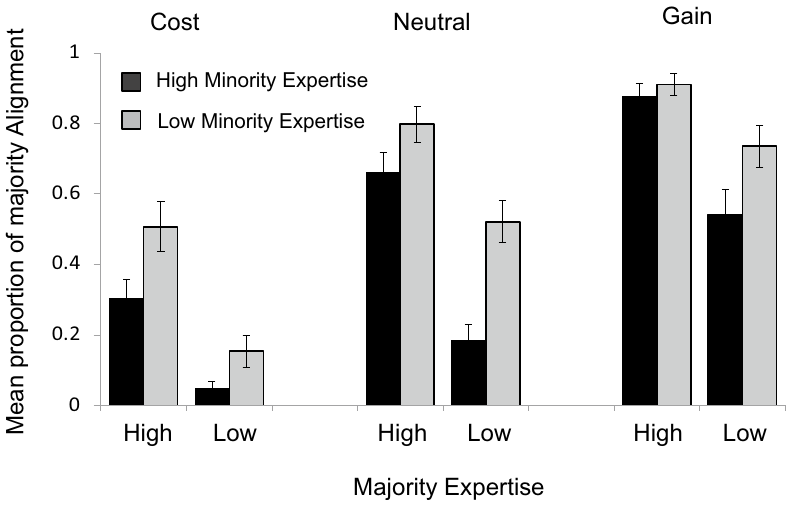
Figure 4. Results . Mean proportion of choosing the option endorsed by the majority of previous gamblers given that the majority endorsed an option with a lower (Cost), greater (Gain), or equal (Neutral) reward probability than the option endorsed by the minority, and given the High vs. Low earnings (i.e., expertise) of Majority and Minority members, respectively. Error bars =